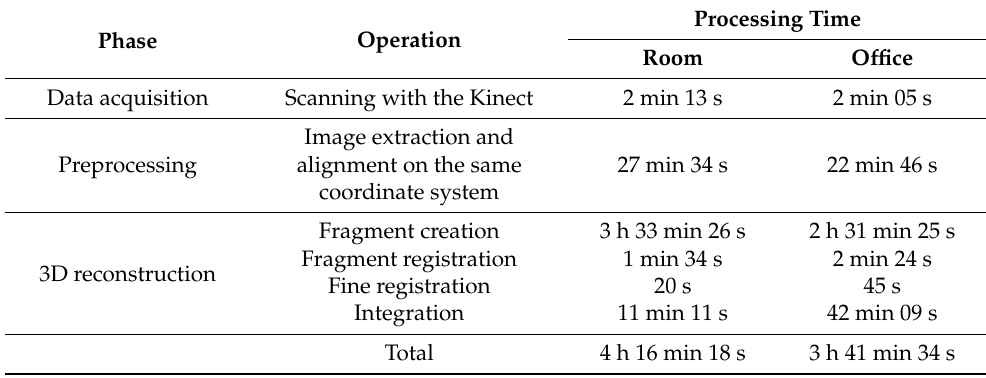
Table 2. Time spent during data acquisition and processing for 3D reconstruction.